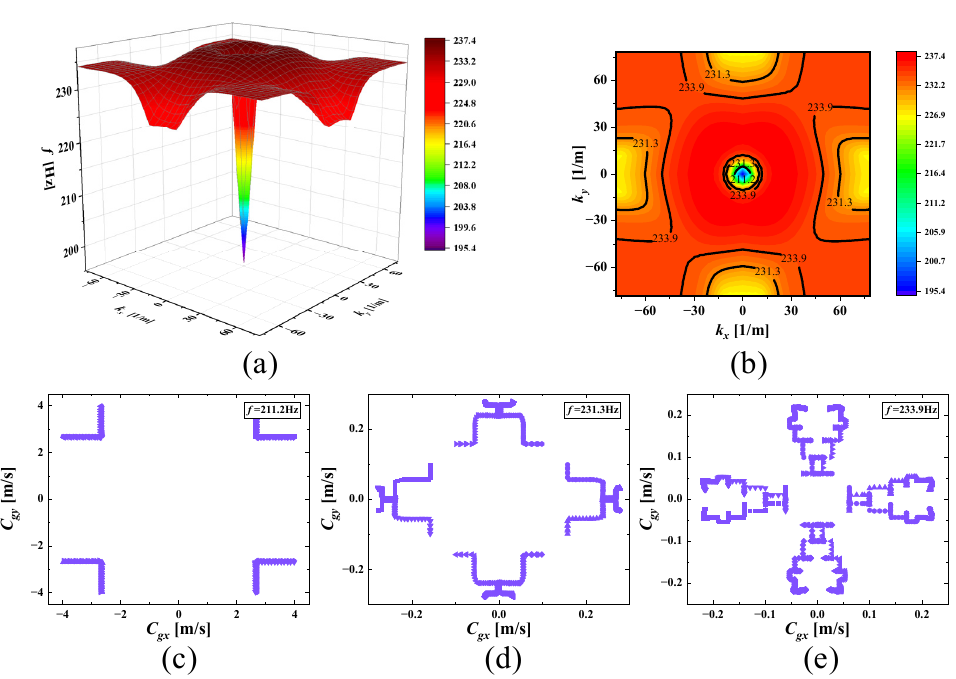
Figure 9. ( a ) Sixth mode; ( b ) ISO-frequency contours; ( c – e ) group velocity of sixth wave mode at 211.2 Hz, 231.3 Hz, and 233.9 Hz.